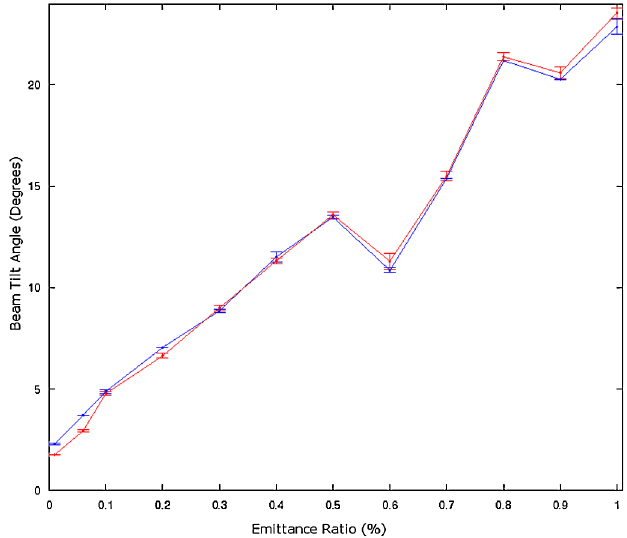
FIG. 9. Measured (blue) and model predicted (red) beam tilt angles at XDB source point. An offset of 1.06 degrees has been subtracted from the measurements to account for the relative tilt of the CCD.